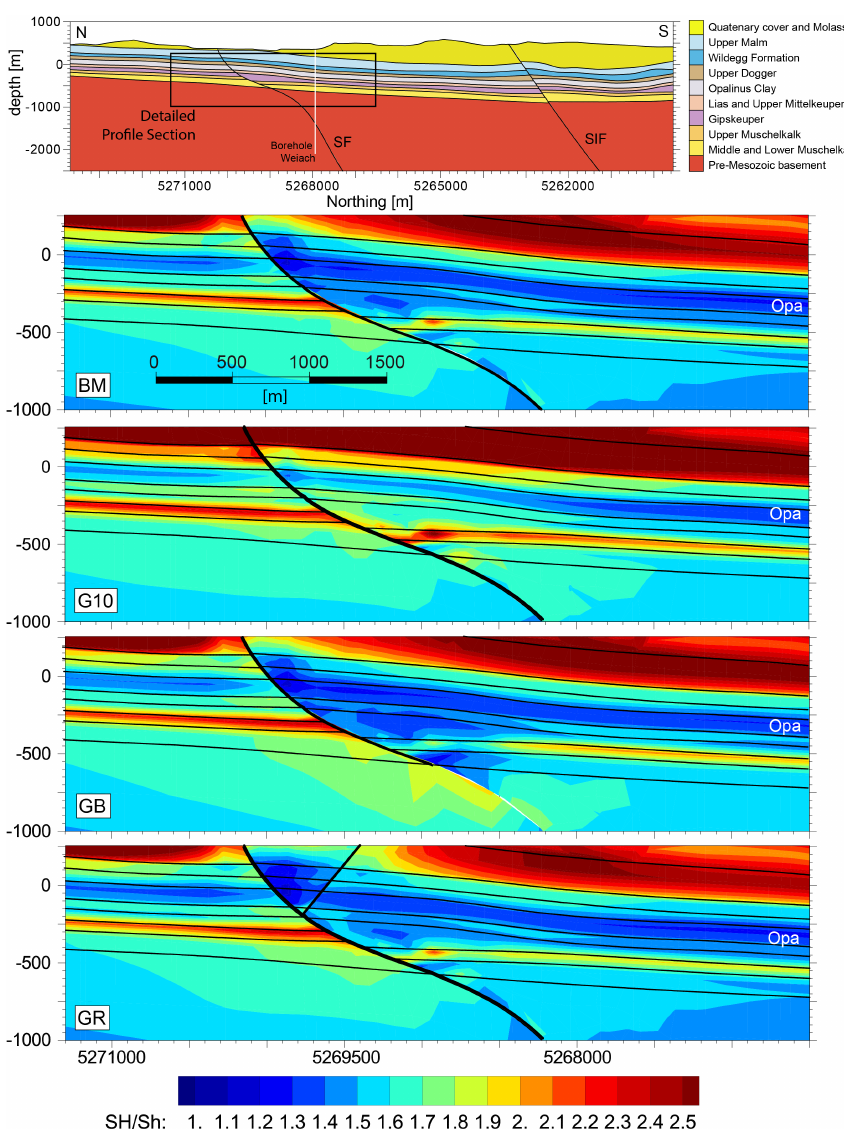
Figure 15. S H /S h in north–south cross section through the Weiach well for different fault geometries. BM is the base model, G10 the model with µ (cid:48) = 1.0GB the model where the SF is inactive in the pre-Mesozoic basement and GR the model with a generic back thrust. Box in the upper figure shows location of the